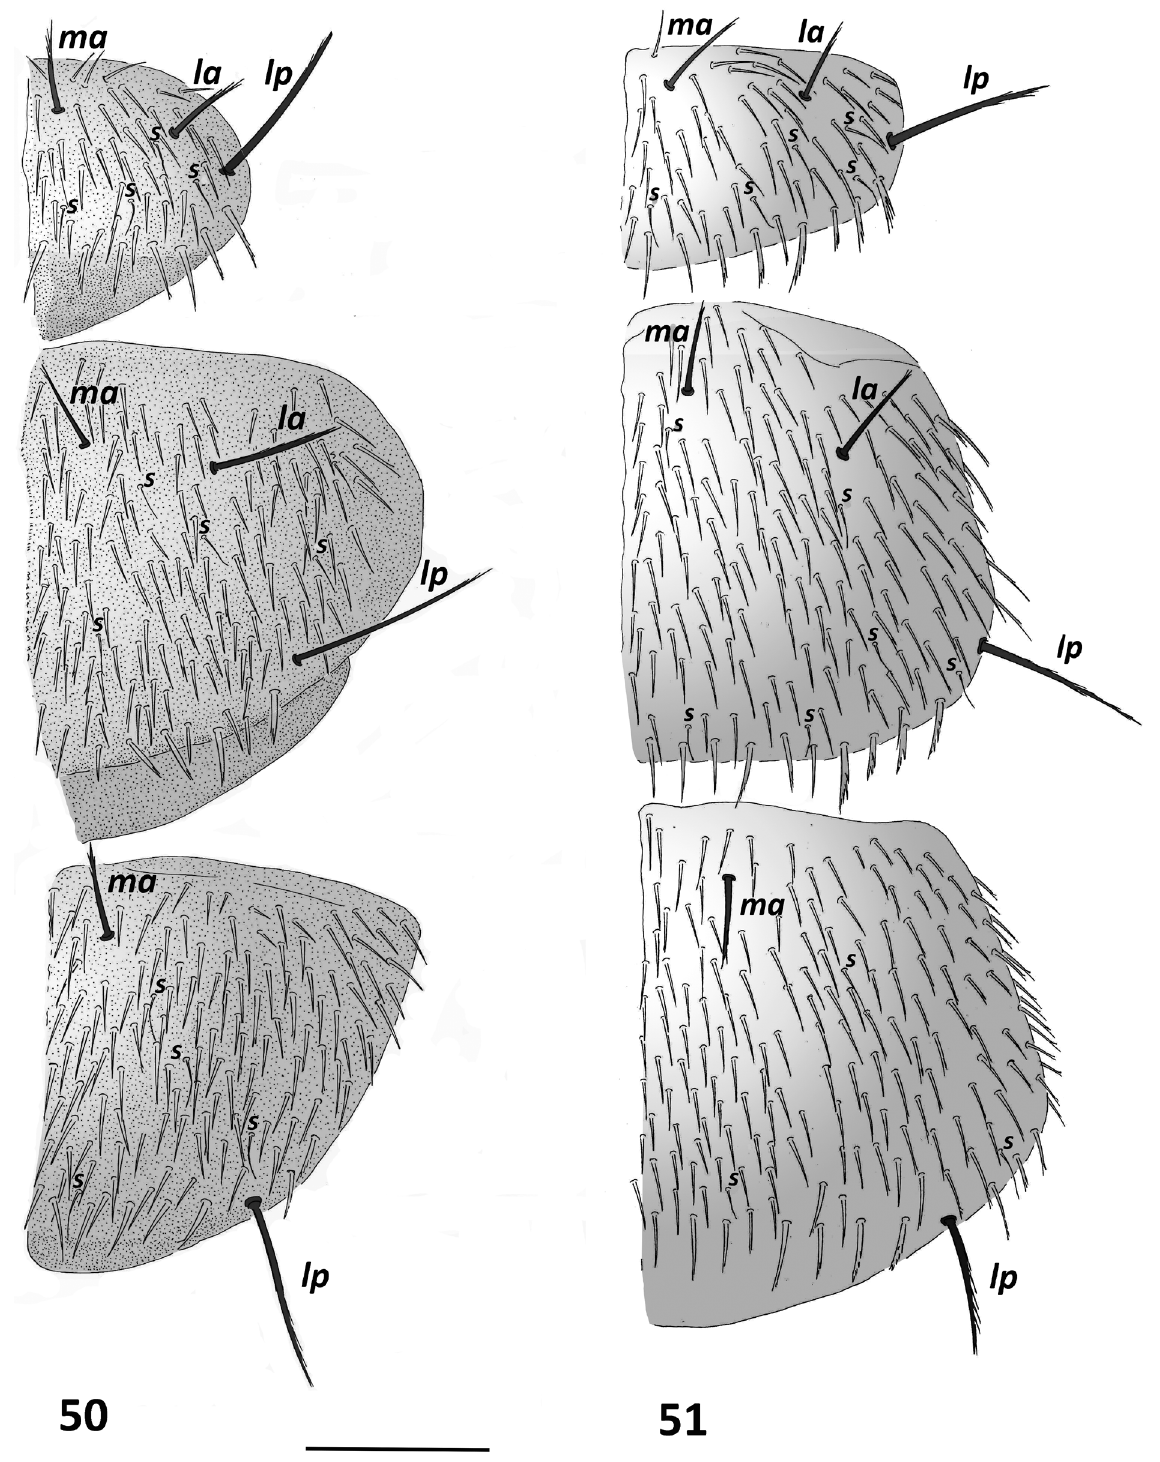
Figs 50–51. – 50 . Campodea ( Campodea ) silvicola Wygodzinsky, 1940, ♂, 4 mm, from Roche Vuti, Switzerland, pronotum, mesonotum and metanotum. – 51 . Campodea ( Campodea ) taunica Marten, 1939, ♀, 4.2 mm, from Stâne, Romania, pronotum, mesonotum and metanotum. Abbreviations: see Material and methods. Scale bar: 50 = 0.2 mm; 51 = 0.1